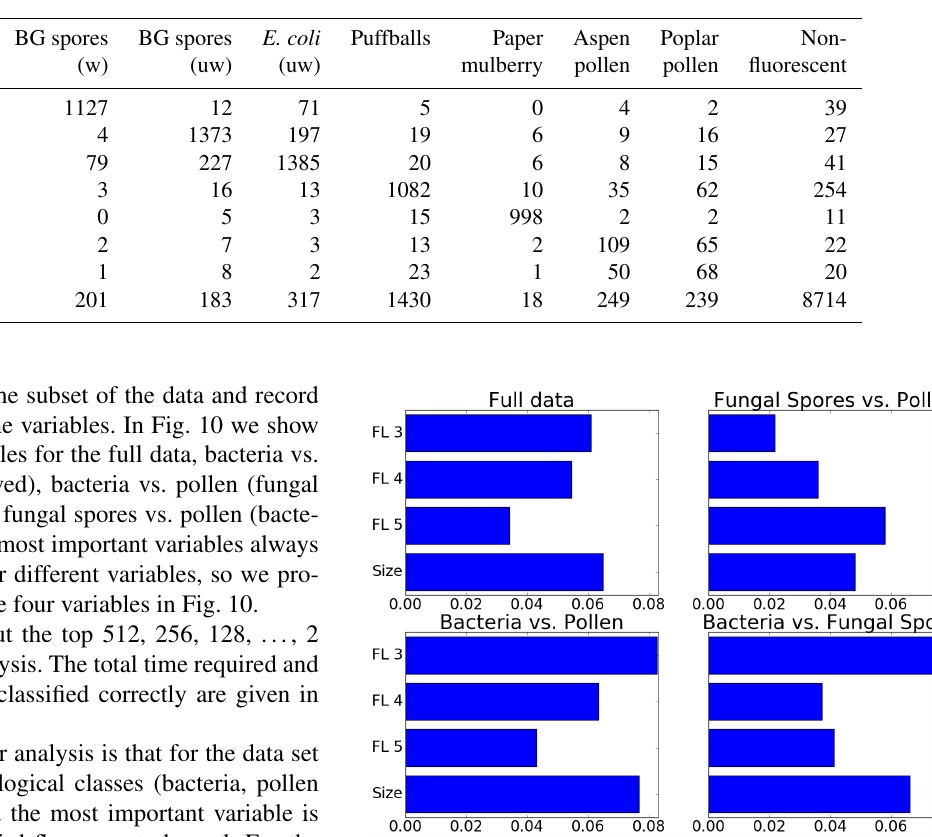
Figure 10. Variable importance for the different subsets of the data.